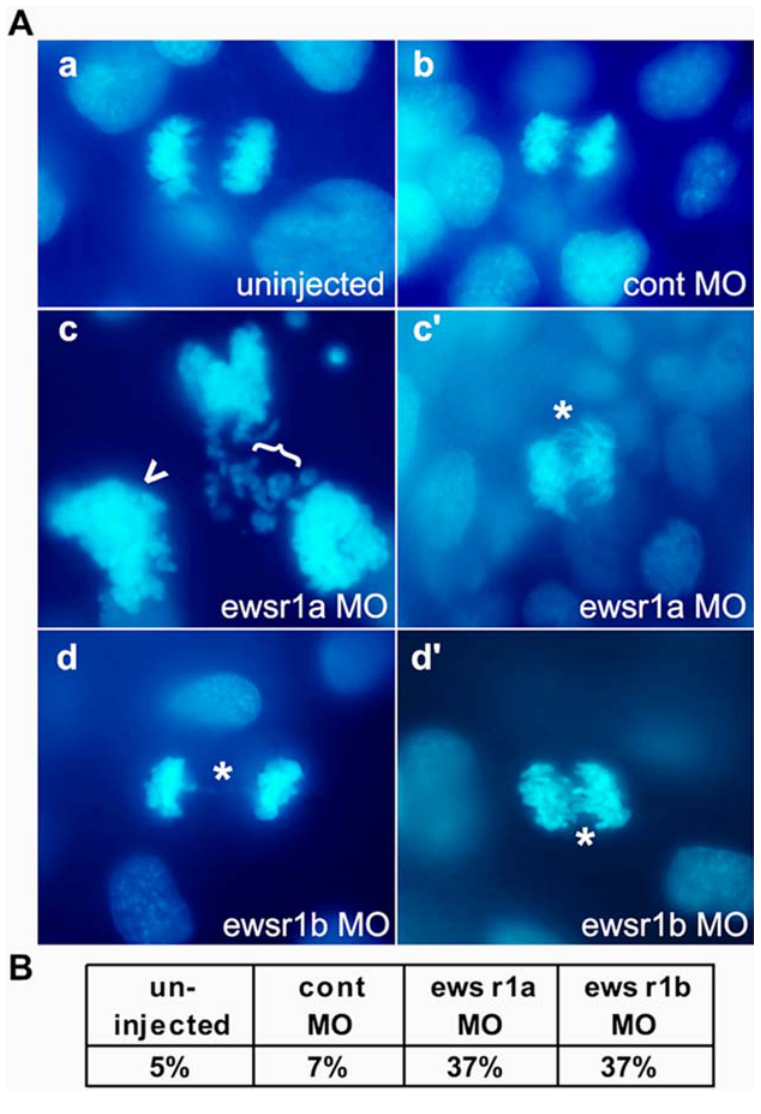
Figure 6. ewsr1MO Injected Zebrafish Embryos Display Genomic Instability. A. Representative images of mitotic spindles from (a) uninjected, (b) control MO, (c and c’) ewsr1a MO and (d and d’) ewsr1b MO injected embryo. DNA was stained with DAPI (blue). Asterisks (*) identify chromosome bridges. (c) The cell appears to be the result of aberrant chromosomal segregation. ({) points to missegregated chromosomes and arrowhead ( , ) to a possible additional chromosome set. B. Percentage of chromosome bridges per hundred anaphase chromosomes of uninjected, control MO, ewsr1a MO and ewsr1b MO injected embryos at the 12 somite stage (12sm).